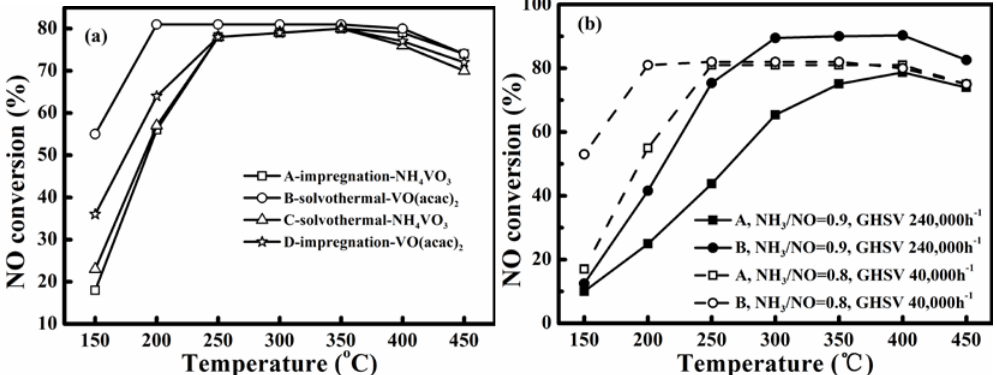
Figure 1. ( a ) NO conversions of four prepared catalysts A to D for simulated flue gas without SO 2 and water vapor; ( b ) NO conversion of catalyst A and B under different GHSV: NH 3 /NO = 0.8, GHSV 40,000 h − 1 , and NH 3 /NO = 0.9, GHSV 240,000 h − 1 . (Gas compositions in Experimental section).